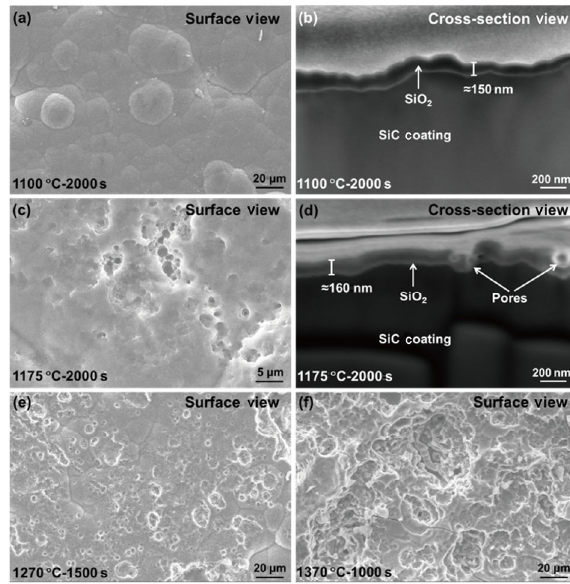
Fig. 4 Surface microstructural evolution of C f /SiC after dynamic oxidation at ~1 kPa: (a, b) ~1100 ℃ for 2000 s, (c, d) ~1175 ℃ for 2000 s, (e) ~1270 ℃ for 1500 s, and (f) ~1370 ℃ for 1000